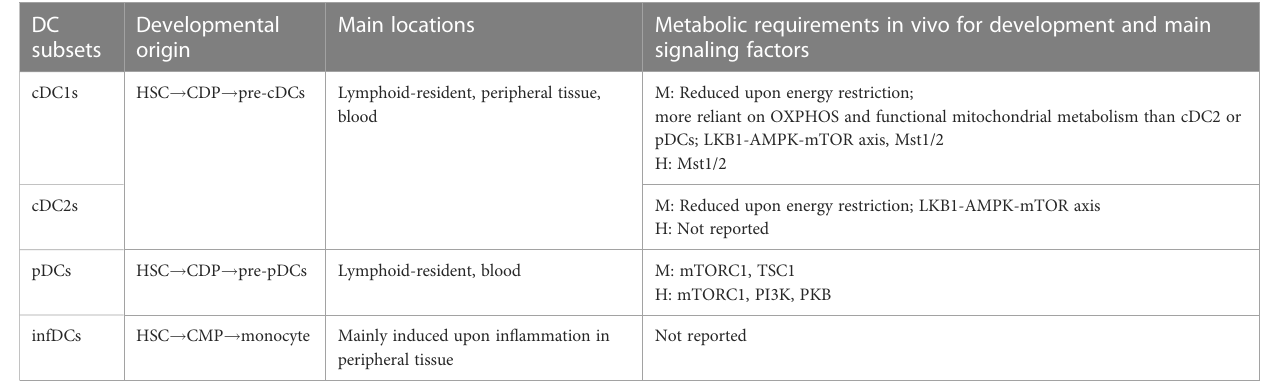
TABLE 2 Metabolic regulation of DC subsets in